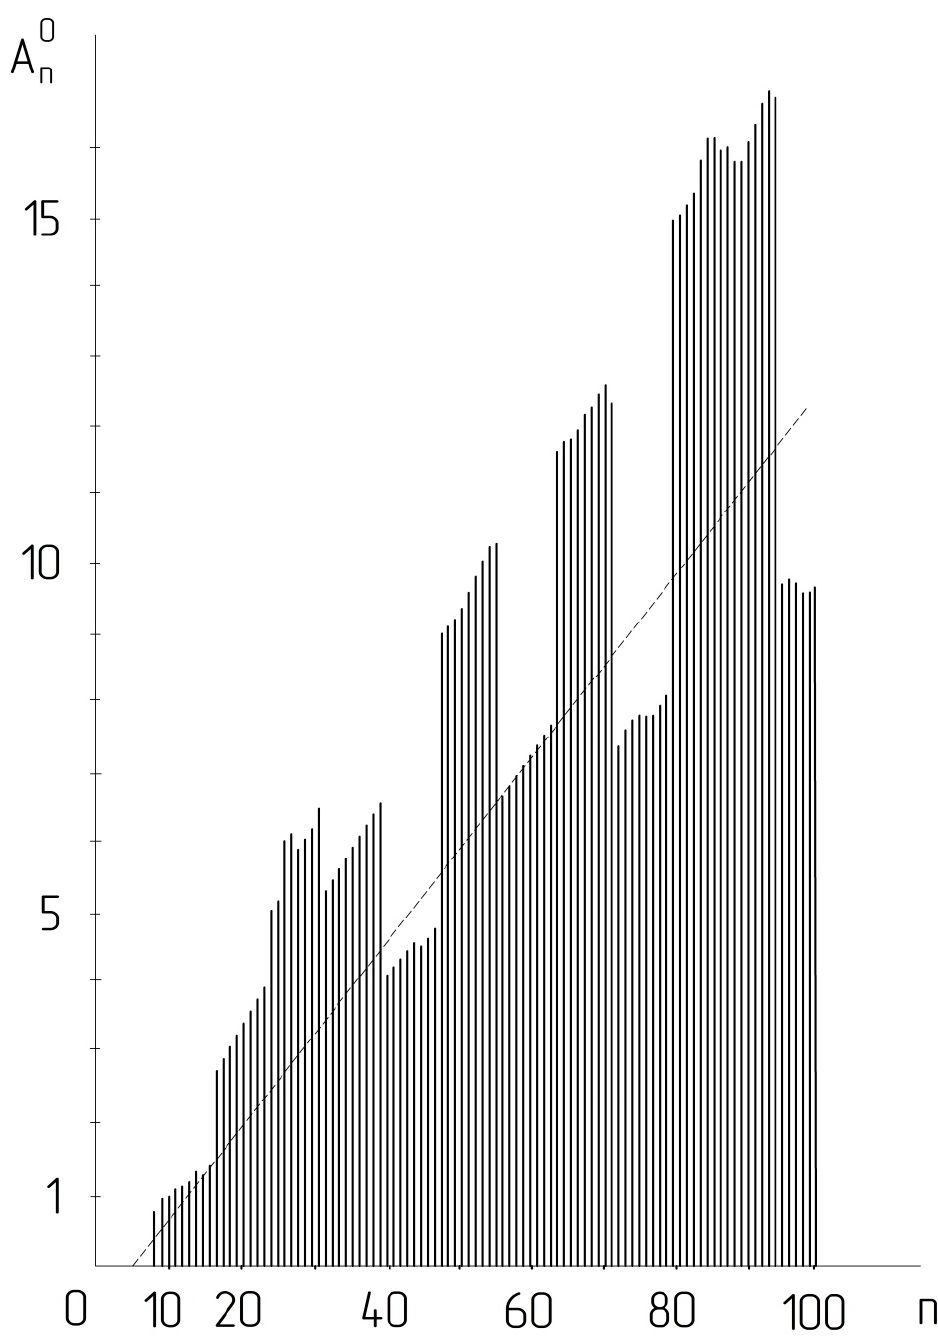
Figure 11. The rotor system spectrum with the triangular modulation function and the number of places m = 1528.